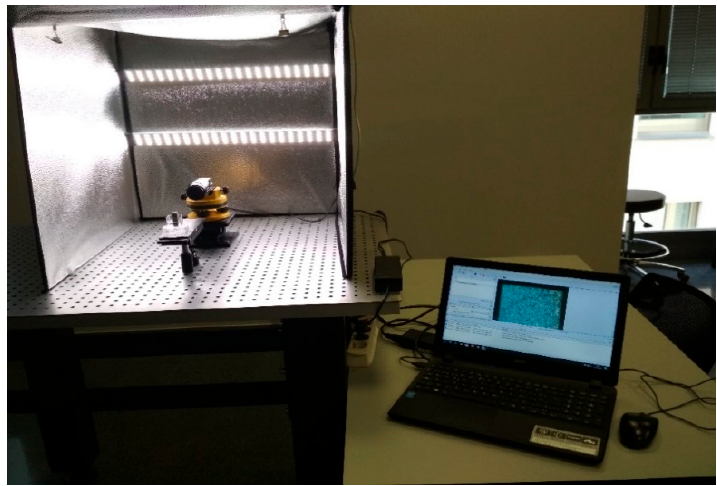
Figure 3. Photo studio light box, with one of its sides open.